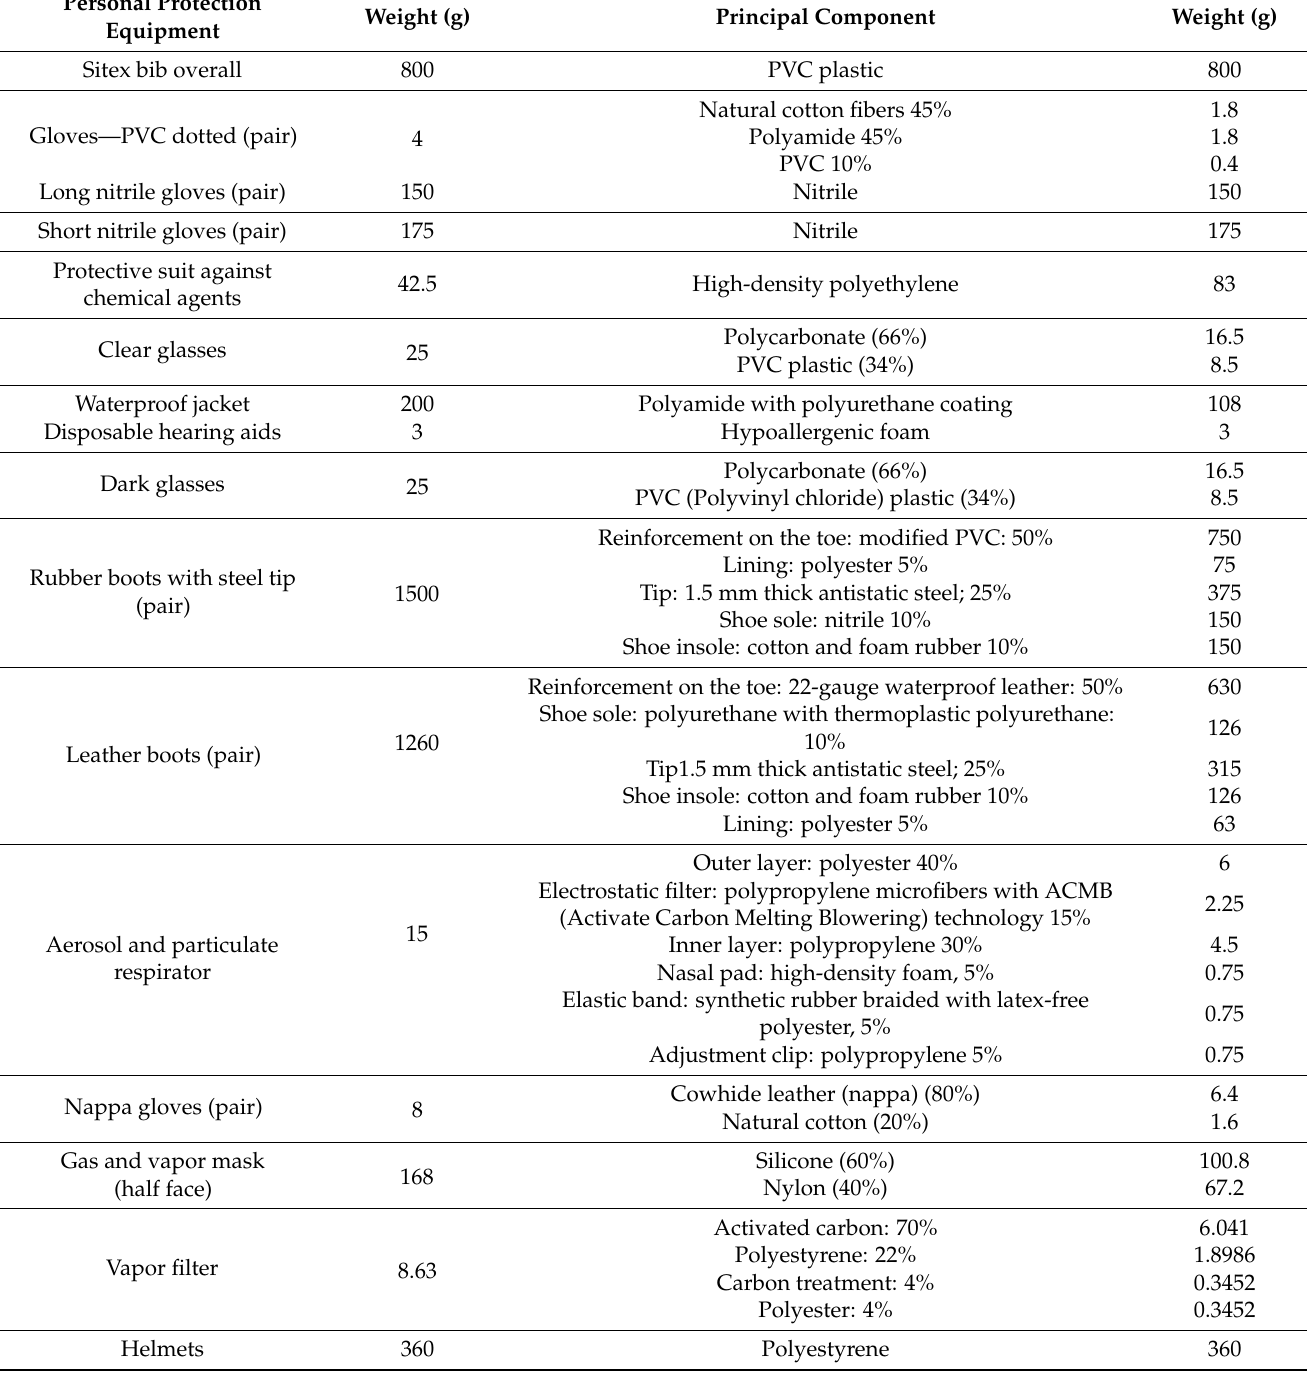
Table 1. Main components of tools, supplies and personal protective equipment in the environmental remediation process. Personal